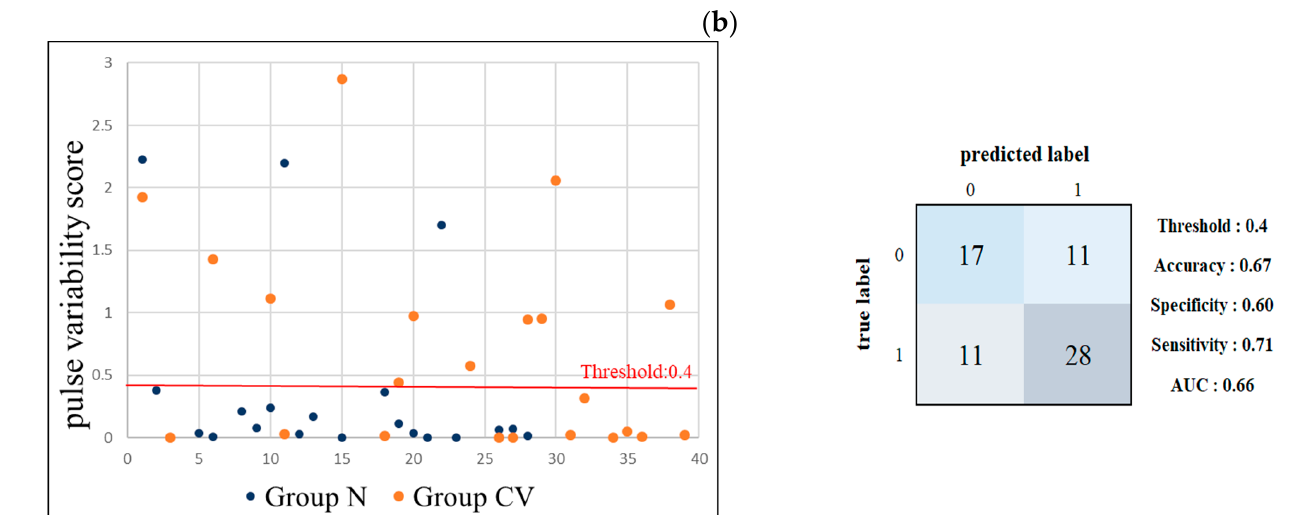
Figure 7. Results of pulse-variability score analysis of BPW indices for discrimination between Groups N (0; n = 28) and CV (1; n = 39). ( a ) Threshold = 40 produced accuracy = 62.68%, specificity = 0.96, sensitivity = 0.38, and AUC = 0.67. All but one of the subjects with a score >40 ( n = 16; right side of the confusion matrix) experienced cardiovascular side effects. ( b ) Threshold = 0.4 produced accuracy = 67.16%, specificity = 0.60, sensitivity = 0.71, and AUC = 0.66. The sensitivity of 0.71 indicates that 71% of the subjects with cardiovascular side effects (the lower half of the confusion matrix) were accurately identified.